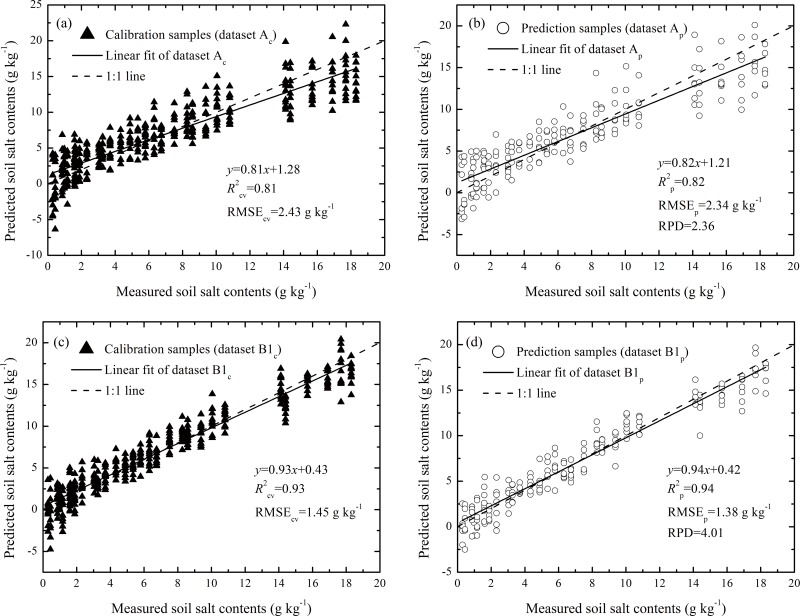
Scatter plots of the measured vs. predicted soil salt contents (SSCs) that were derived from the PLSR analysis of soil spectra based on subsets (a) Ac, (b) Ap, (c) Bc, and (d) Bp.